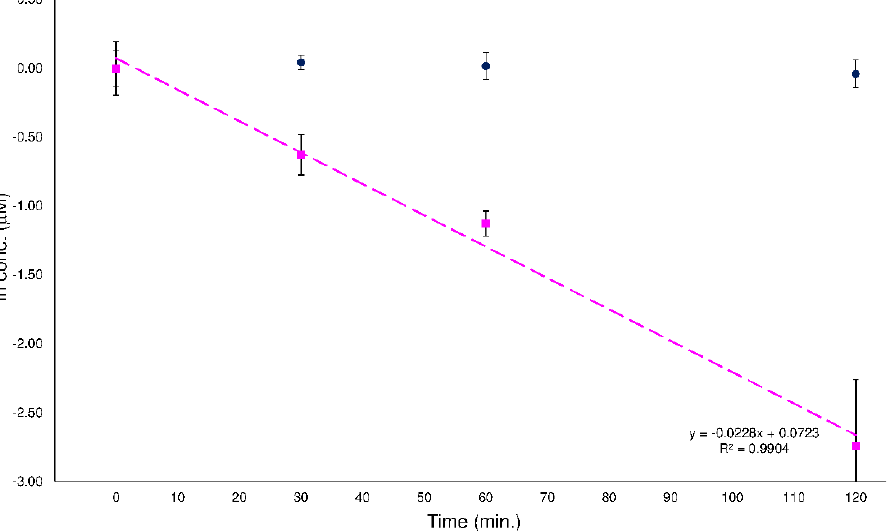
Figure 6. Degradation plots obtained by LEDA elaboration of the human plasma samples spiked with mixtures of the ELF94 (pink squares) and ELF96 (blue circles) isomers.